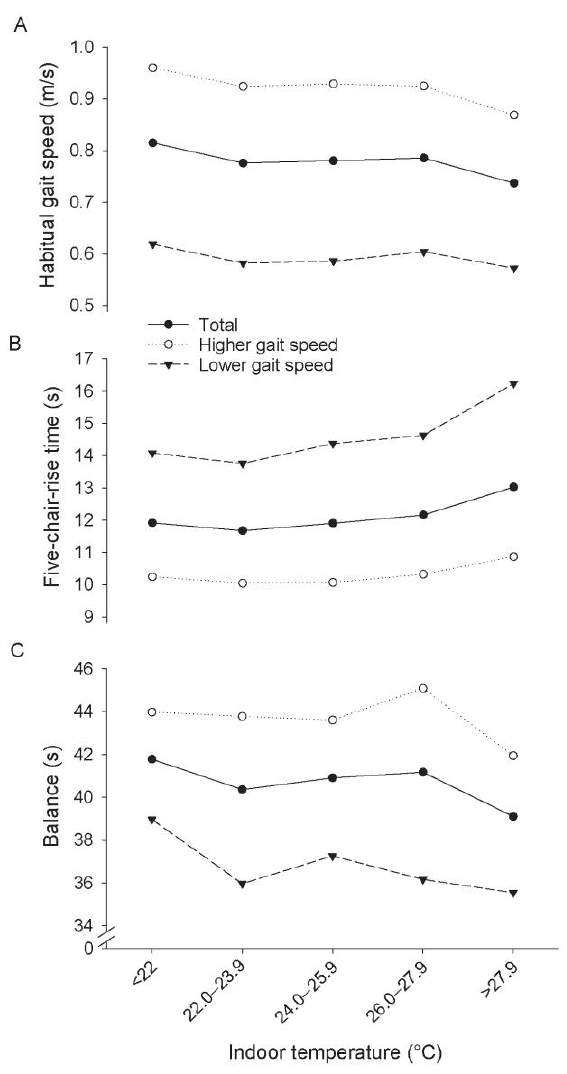
Figure 1. Least-square means from multilevel linear regression analysis of physical performance (habitual gait speed (A), chair-rise performance (B), balance performance (C)) related to grouped indoor temperature and stratified by gait speed (thresholds indication of low gait speed for body heights <159 cm (women)/173 cm (men) = 0.653 m/s and ≥159 cm (women)/173 cm (men) = 0.762 m/s).